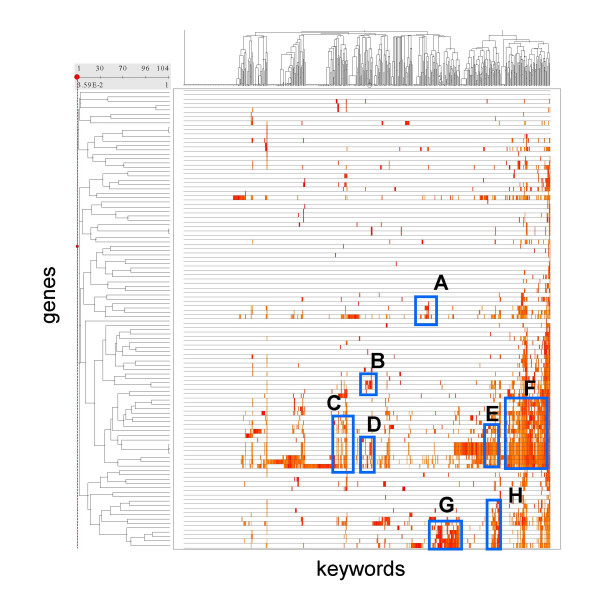
Hierarchical clustering of literature co-occurences of 104 genes (rows) versus 761 biological processes and diseases (columns). A co-occurrence was only taken into account when at least three articles mention the gene-keyword pair. Hierarchical clustering of CoPub Mapper results using genes differentially expressed in PCOS ovaries. From 221 regulated genes 104 genes contain a gene name, symbol or alias and produce a gene-keyword pair with biological processes or diseases. 104 modulated genes returned 761 keywords denoting biological processes or diseases. Hierarchical clustering was performed using Spotfire using the Complete Linkage method and Correlation as Similarity Measure. Several subclusters were identified shown here with blue boxes; between parenthesis the number of genes in a cluster. A: PCOS, Obesity, Insulin Resistance (4); B & D: Gametogenesis (5&8); C: Cell adhesion, Angiogenesis (19); E & H: Immune response, Inflammation (14&11); F: Cancer, Cell growth, Differentiation (32); G: Inflammatory diseases (6).